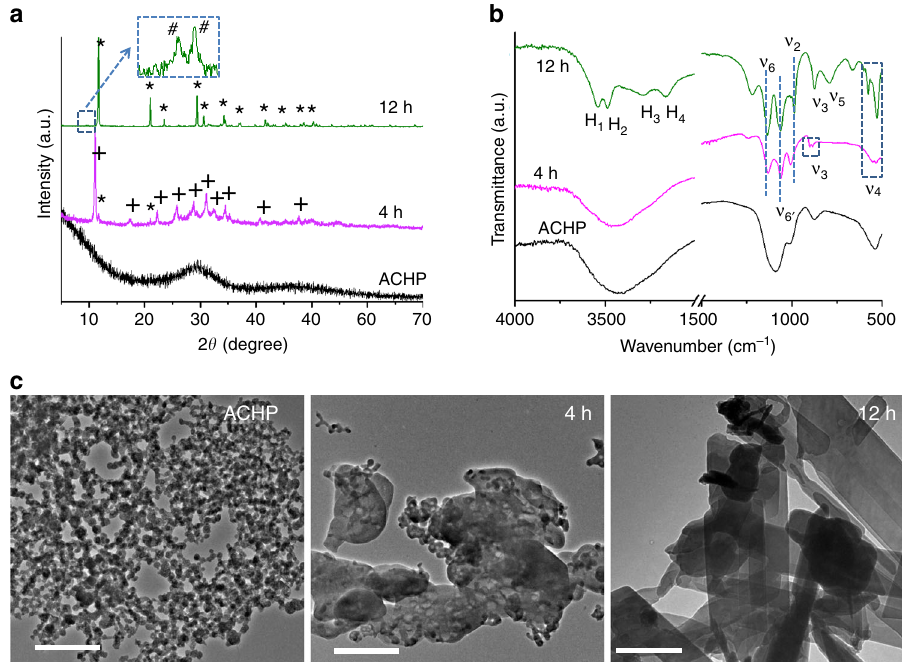
Fig. 4 Formation of DCPM from ACHP in wet air. XRPD patterns ( a ), IR spectra ( b ) and TEM micrographs ( c ) of ACHP in wet air (25 °C, 95% humidity) after different times as indicated. In the XRPD patterns ( a ), the symbols *, + and # mark the diffraction peaks of DCPD, DCPM; and OCP, respectively. The inset magni fi es the diffractogram of the sample (12 h) in the range of 8 – 10° 2 θ . In the IR spectra ( b ), “ ν i ” represent different vibrational modes i of the phosphate ion; H 1 – H 4 indicate the ν (OH) modes of four different hydrogen bonds of structural H 2 O. The assignment of vibration modes follows Bailey et al. 48 . All scale bars: 500 nm. Source data are provided as a Source Data fi le.